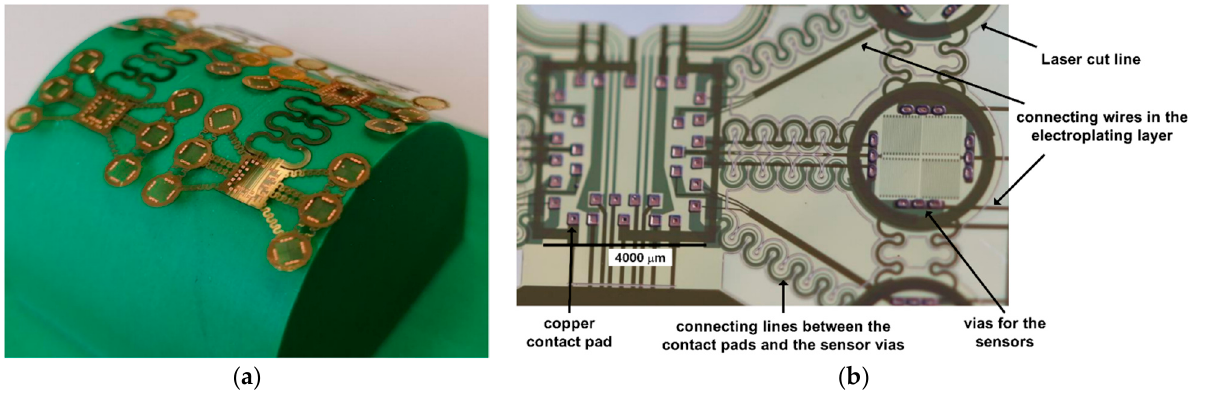
Figure 6. ( a ) Freely bendable sensor array was peeled off the glass wafer after laser cutting. ( b ) Detail view showing 32 contact pads in the area reserved for soldering the chip and 12 micro-vias in the area of one sensor node.